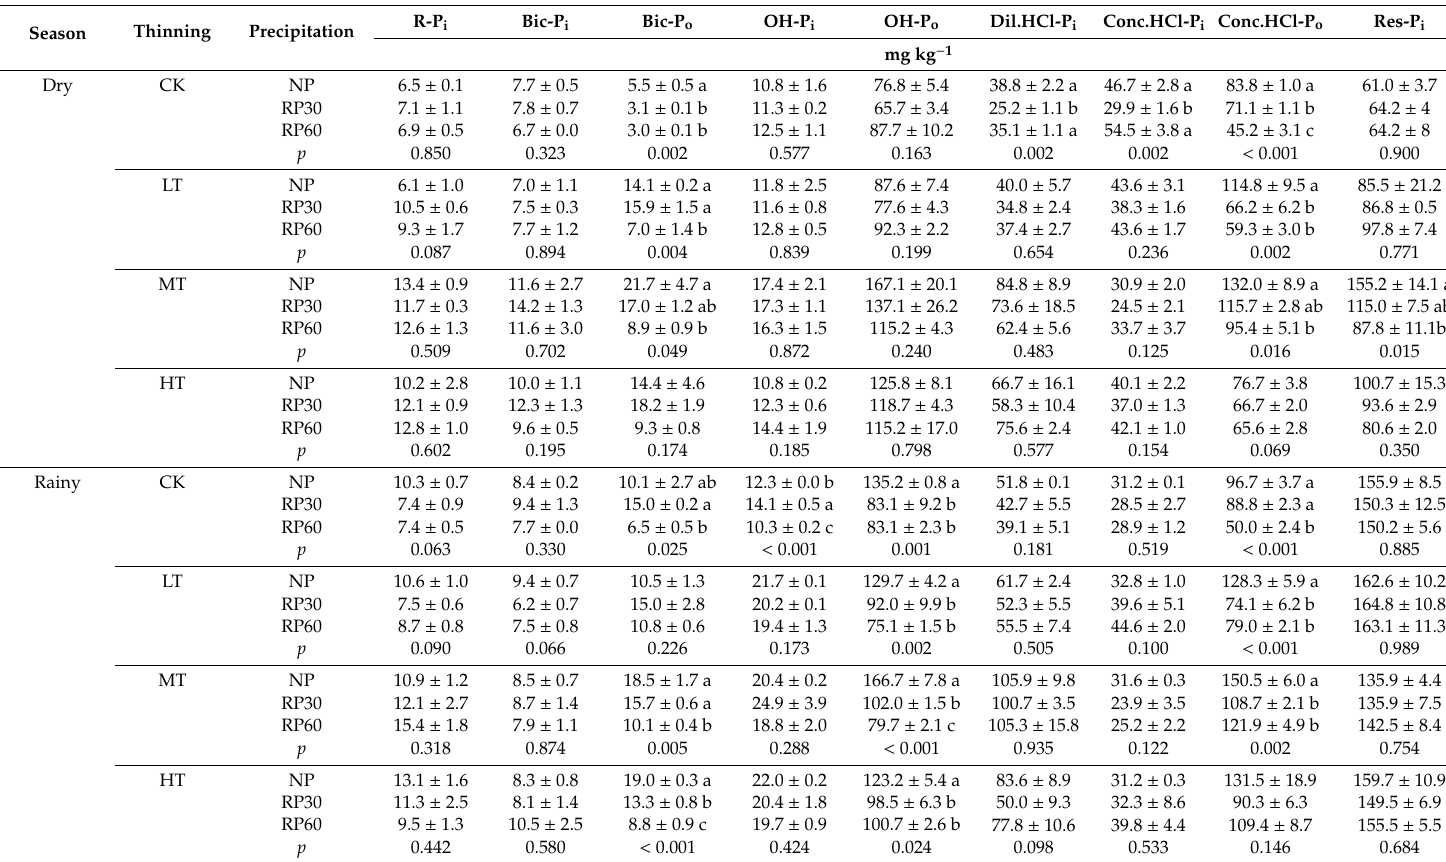
Table 2. Soil phosphorus fractions in the dry and rainy seasons under di ff erent precipitation and thinning treatments in L. principis - rupprechtii